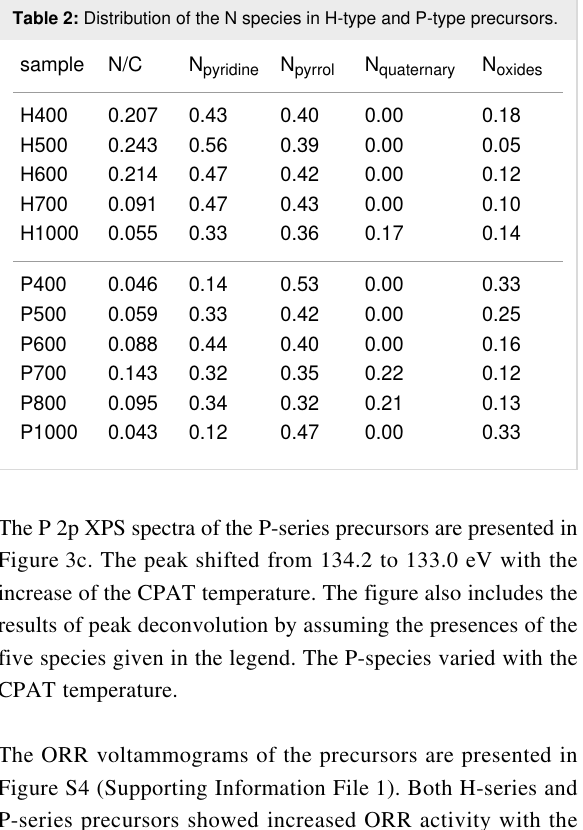
Table 3: BET-SSAs and XPS-determined elemental surface composi- tions of HH- and PH-series carbon